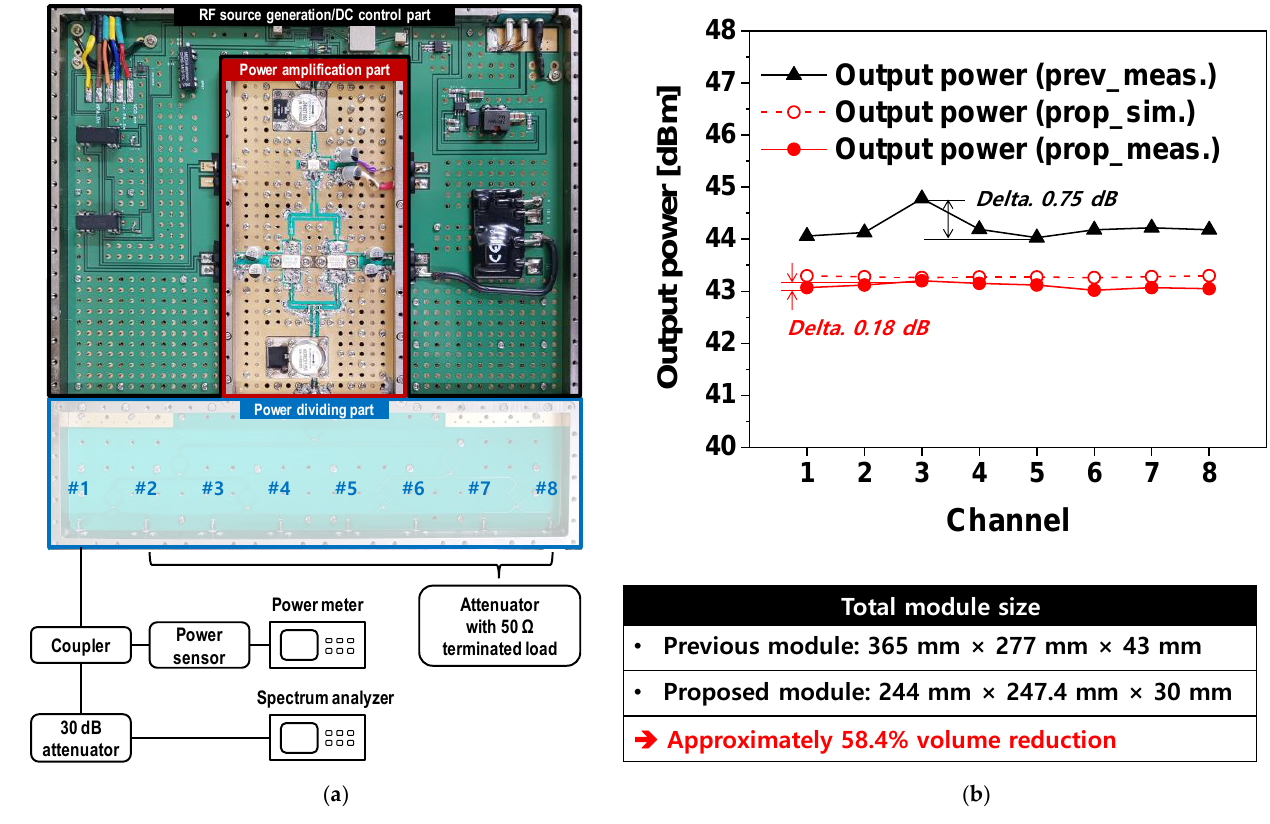
Figure 9. ( a ) Photograph of the proposed RF source module with measurement setup; ( b ) measurement results of each channel.